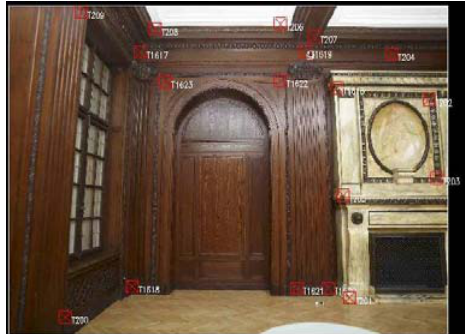
Picture 8: Completed sketch of pass points for photogrammetric analysis